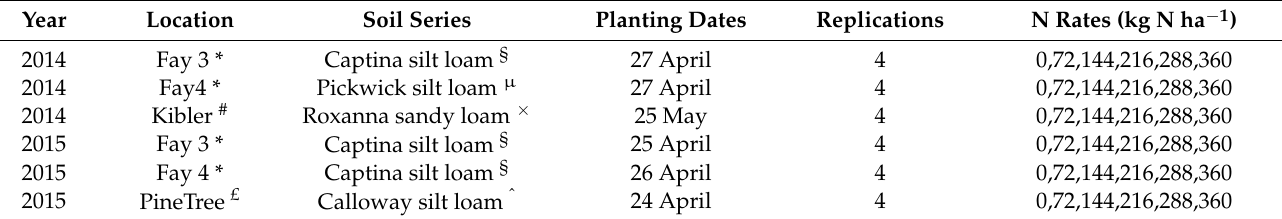
Table 2. Information on field experiments (2014 and 2015).